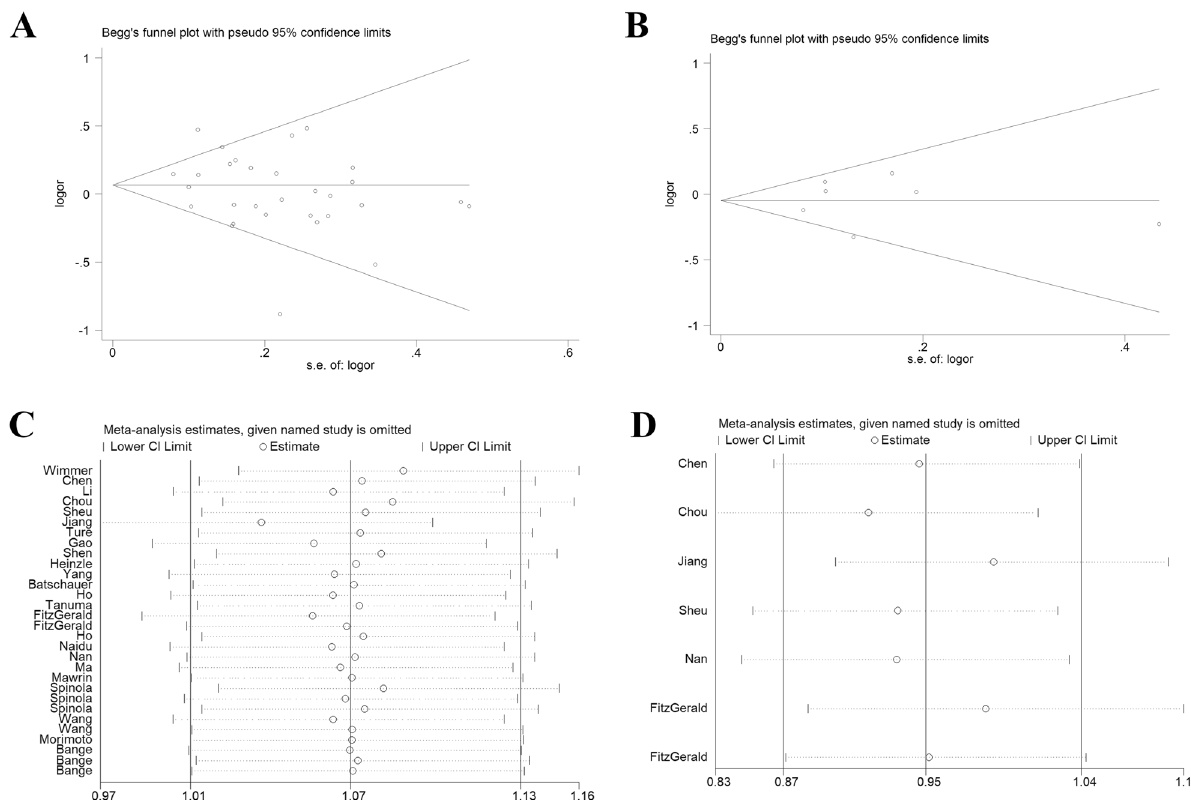
Figure 8. Begg’s funnel plot analysis for FGFR4 G388R ( A ) and V10I ( B ) polymorphisms under dominant genetic model. Sensitivity analysis for FGFR4 G388R ( C ) and V10I ( D ) polymorphisms and risk of cancer. No evidence of publication bias was